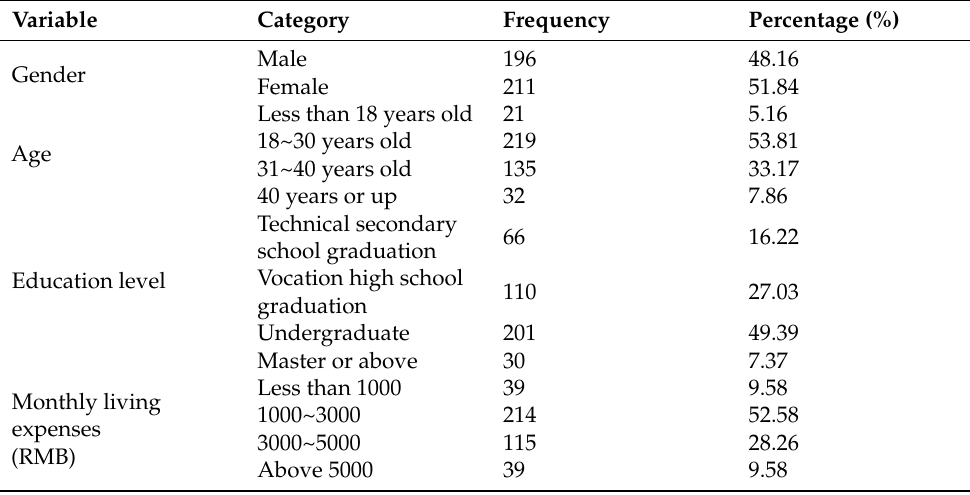
Table 2. Demographic characteristics ( N = 407).